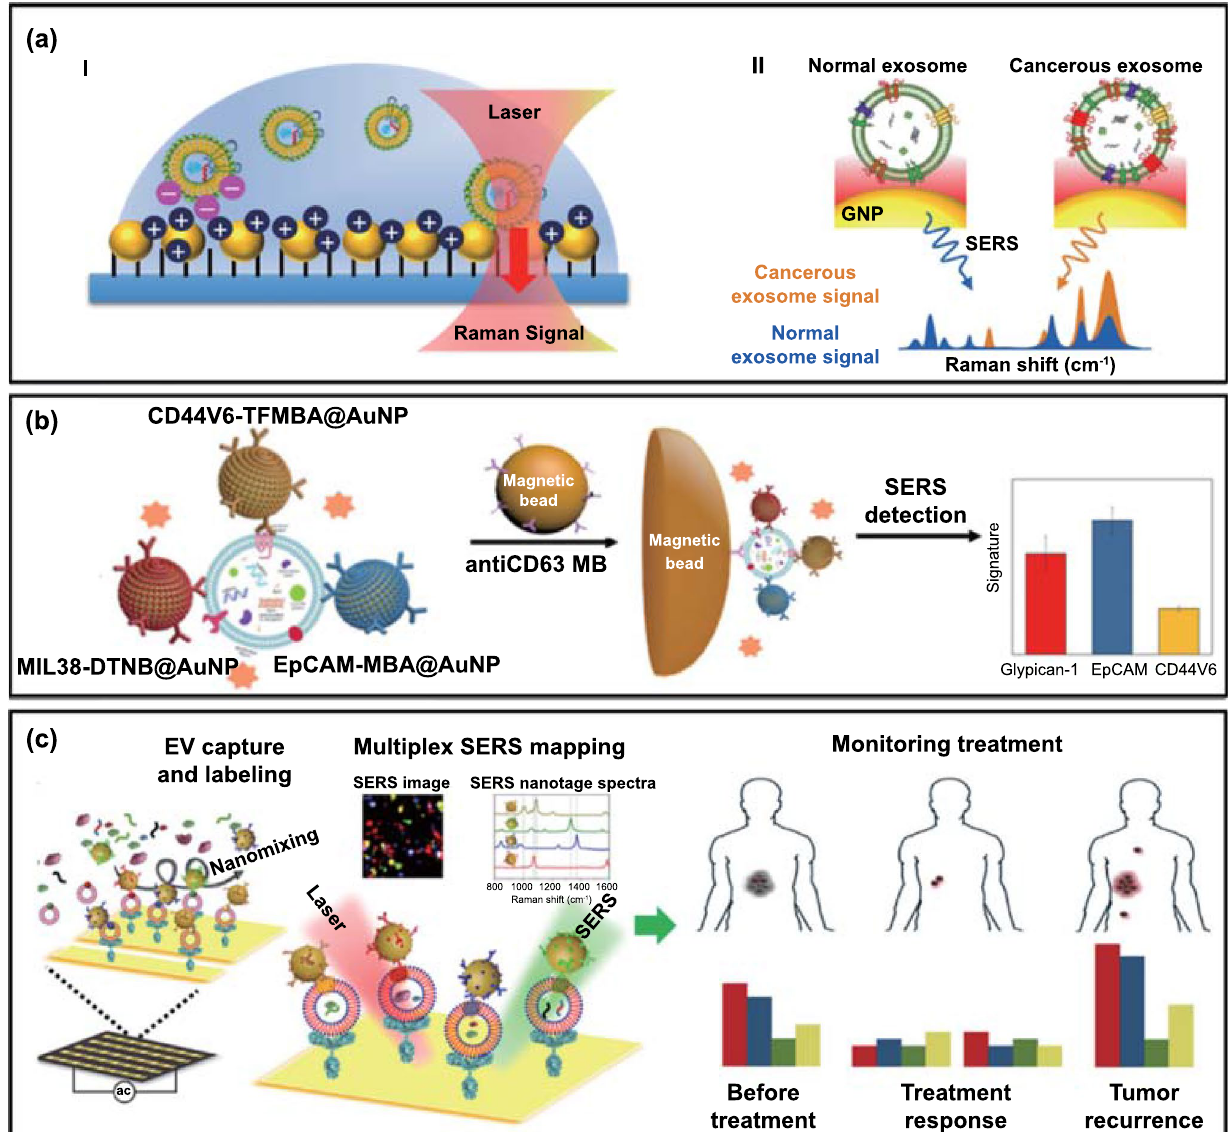
Fig. 3 Typical SERS-based approaches for EV multiplexing. a An examination of multiple EV components using the bulk chemical fingerprints of immobilized EVs. Adapted with permission from Ref. [35]. Copyright 2018 American Chemical Society. b Schematic illustration of molecu- lar phenotype profiling of CD63-positive EVs using SERS nanotags (antibody-Raman dye conjugate: anti-MIL38-DTNB, anti-EpCAM-MBA, and anti-CD44V6-TFMBA). Adapted with permission from Ref. [36]. Copyright 2020 American Chemical Society. TFMBA: 2,3,5,6-Tetra- fluoro-4-mercaptobenzonic acid, DTNB: 5,5’-dithiobis(2-nitrobenzoic acid), MBA: 4-mercaptobenzoic acid. c A multiplex EV phenotype assay chip using four SERS nanotags. The phenotypic evolution can be tracked by analysing EV samples before, during, and after immunotherapy treatment, thus providing information on treatment responses and the early signs of drug resistance. Adapted with permission from Ref. [39]. Copyright 2020 American Association for the Advancement of Science